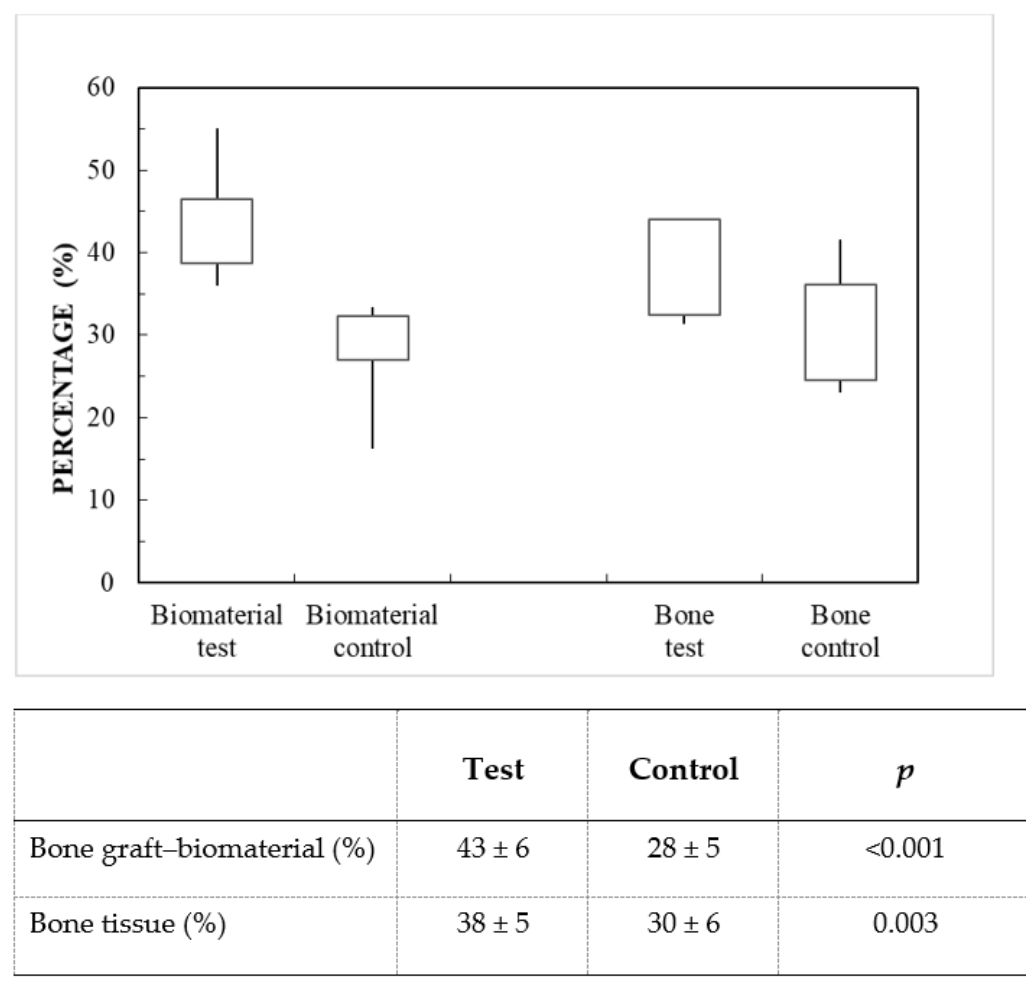
Figure 4. Boxplot and table of the histomorphometric results. Percentage of bone graft (biomaterial) and bone tissue for the test (shark tooth-derived bone graft) and the control (Bio-Oss ® ).